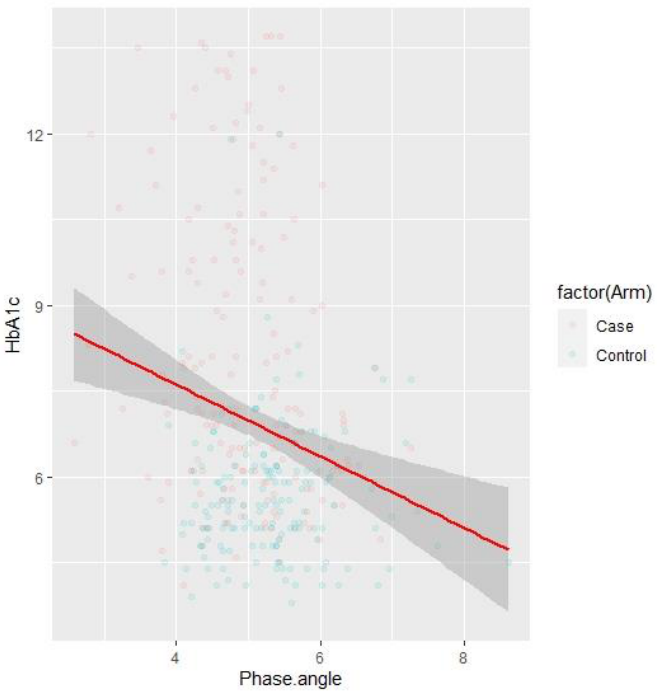
Figure 1. Correlation between Phase Angle and Fasting blood glucose among cases and controls.